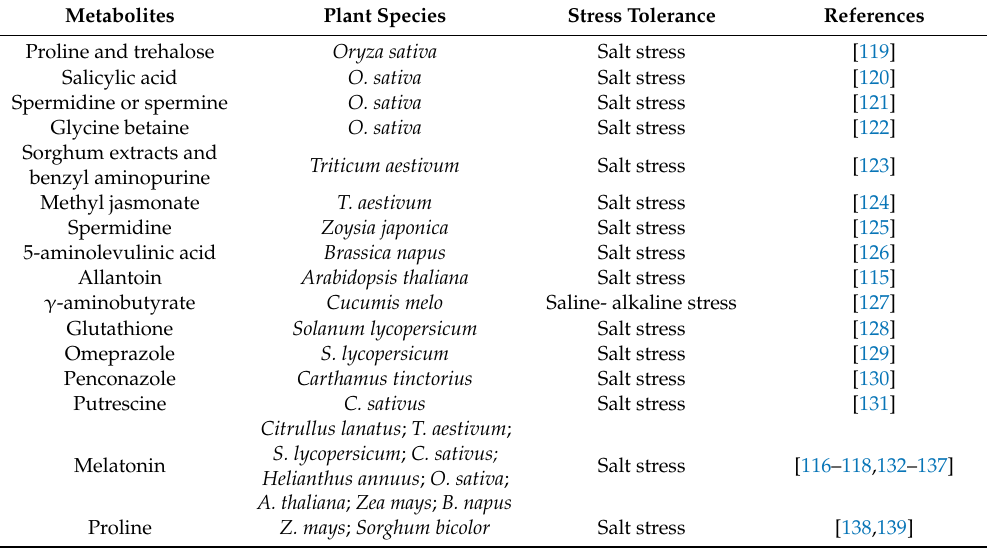
Table 2. E ff ects of exogenous metabolites on the improvement of salt tolerance of treated